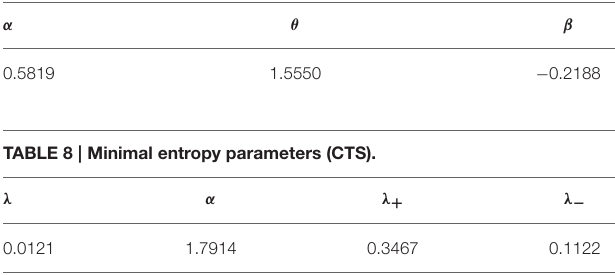
TABLE 7 | Standard NTS parameters.